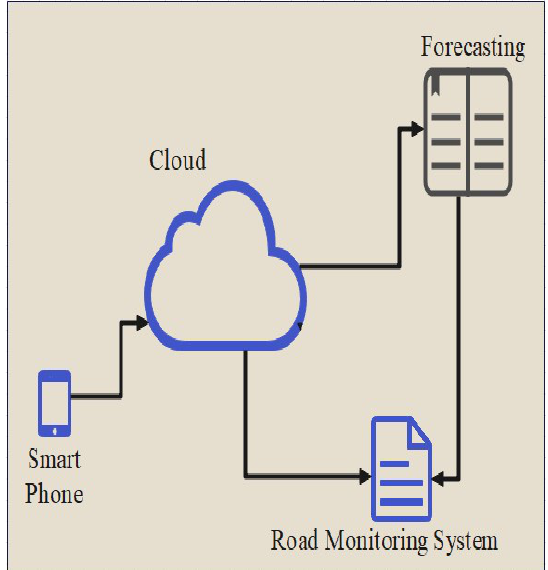
Figure 4 . Architecture of road pavement information sharing system.